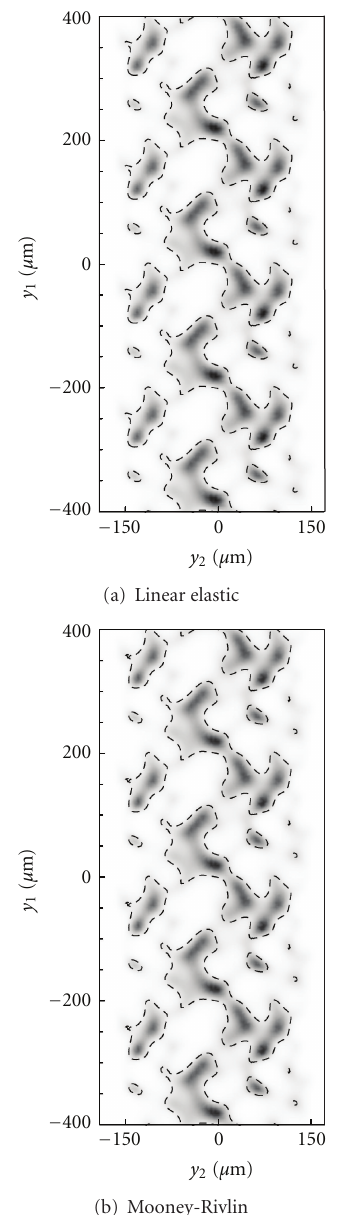
Figure 9: Sample of leakage flux